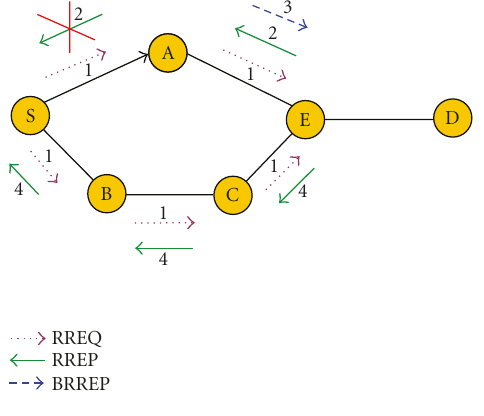
Figure 7: ReversePathSearch